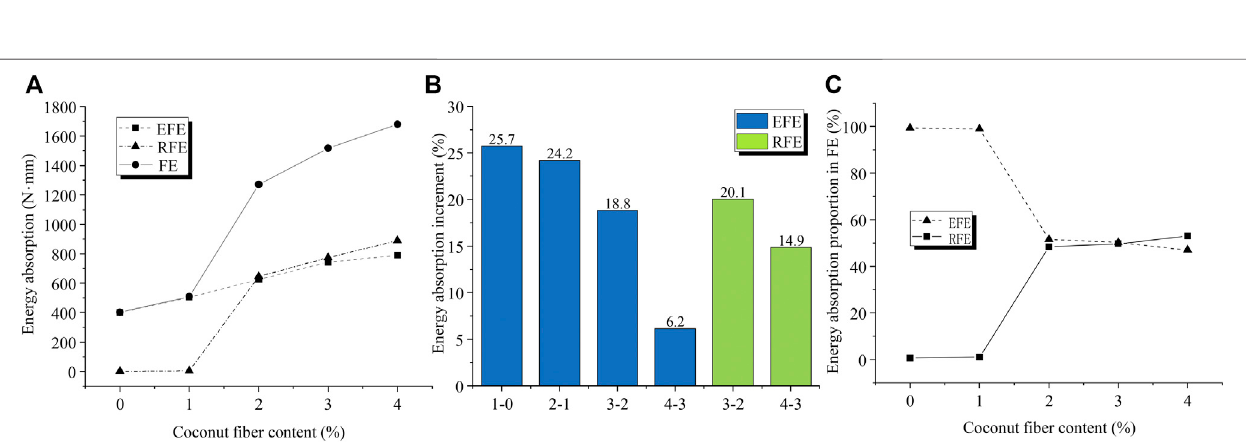
FIGURE 14 | Energy absorption and fl exural toughness (A) energy absorption; (B) energy absorption increment; (C) energy absorption proportion in FE ( *Note: TheabscissarepresentstherelativeincrementforspecimenswithCFofthenumeralbeforeendashtospecimenswithCFofthenumeralaftertheendash.Forexample, 3-2 is the relative increment for specimens with 3% CF to specimens with 2% CF